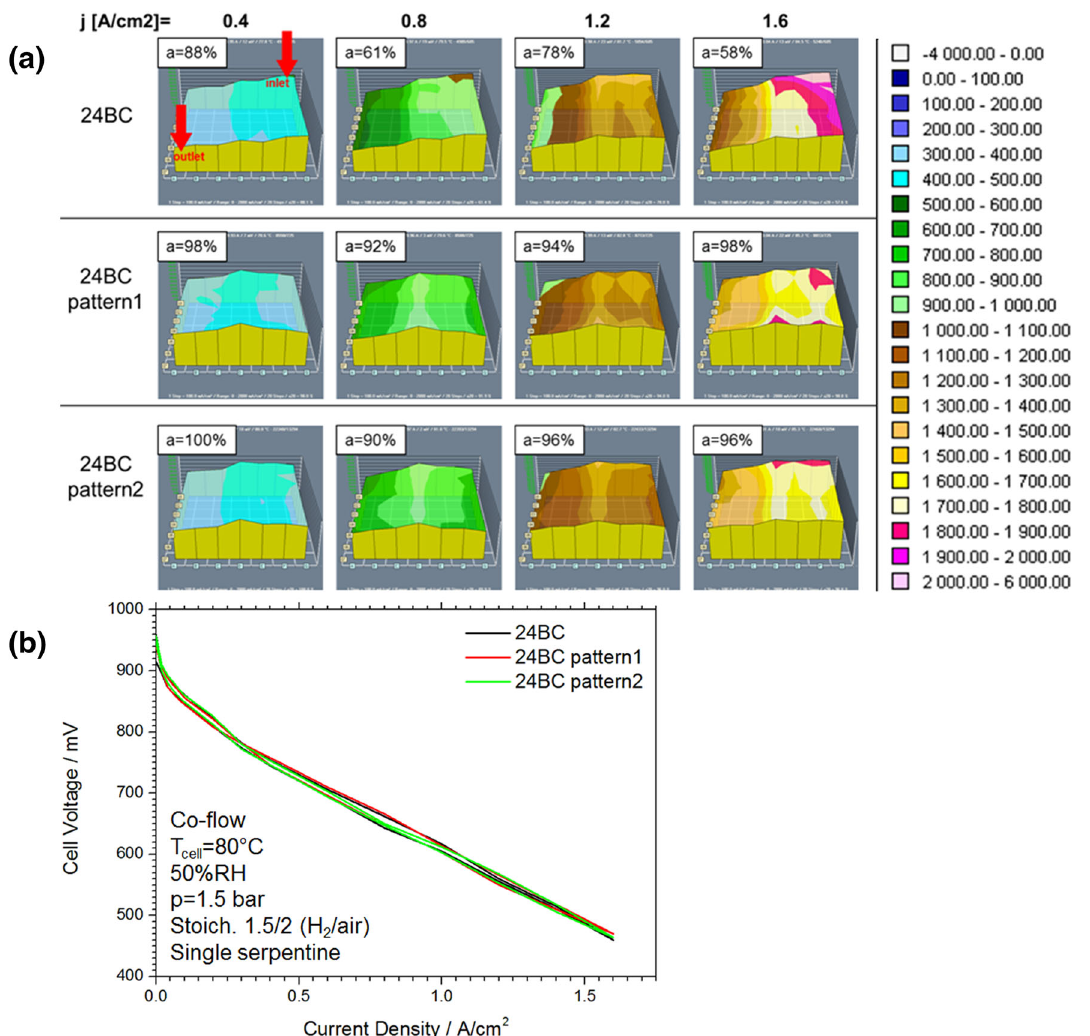
Fig. 4 Current density distributions and polarization curves of MEAs with pristine and modified GDLs measured at 50% RH. a Current density distributions for the pristine GDL, pattern 1 and pattern 2 (compare Fig. 1) recorded at the indicated current densities. The value a is the percentage of values that are within ± 20% range of